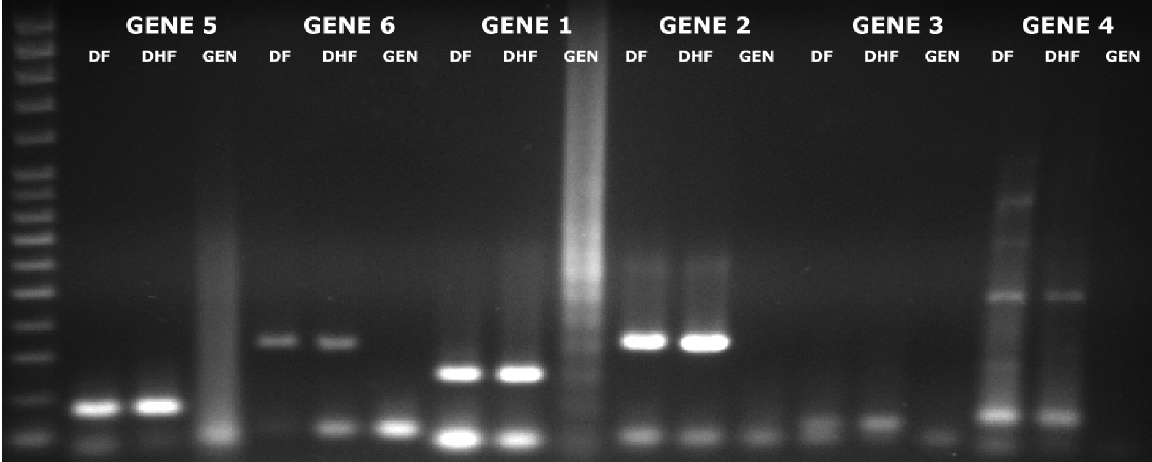
Fig. 1 – Specific amplification of the target genes in DF and DHF samples. DF = cDNA of dengue fever patients, DHF = cDNA of dengue hemorrhagic fever patients and GEN = human genomic DNA. Gene 5 (80 bp) Gene 6 (164 bp) Gene 1 (124 bp) Gene 2 (171 bp) Gene 3 (64 bp)